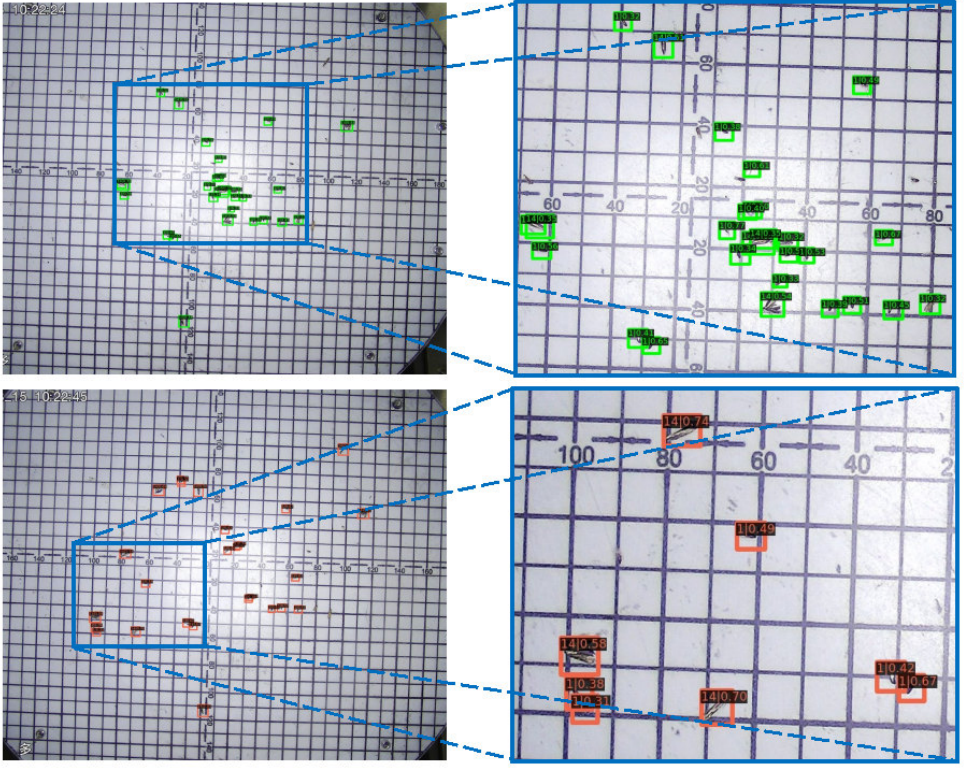
Figure 8. Detection results for tiny pests, Nilaparvata lugens (ID:1) and Hadula trifolii (ID:14).